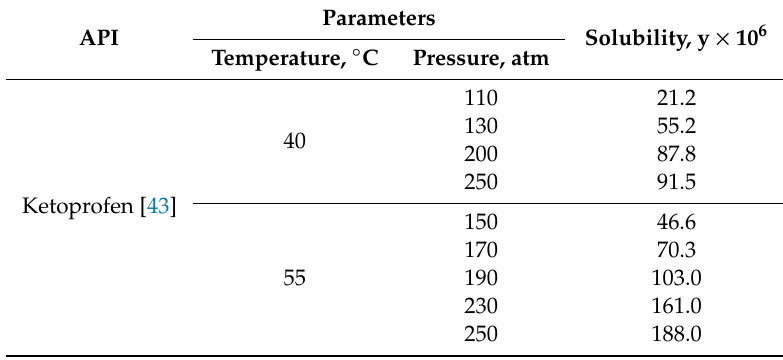
Table 1. Solubility data of selected API (ketoprofen and nimesulide) in supercritical carbon dioxide (y—mole fraction solubility (mole solute / mole